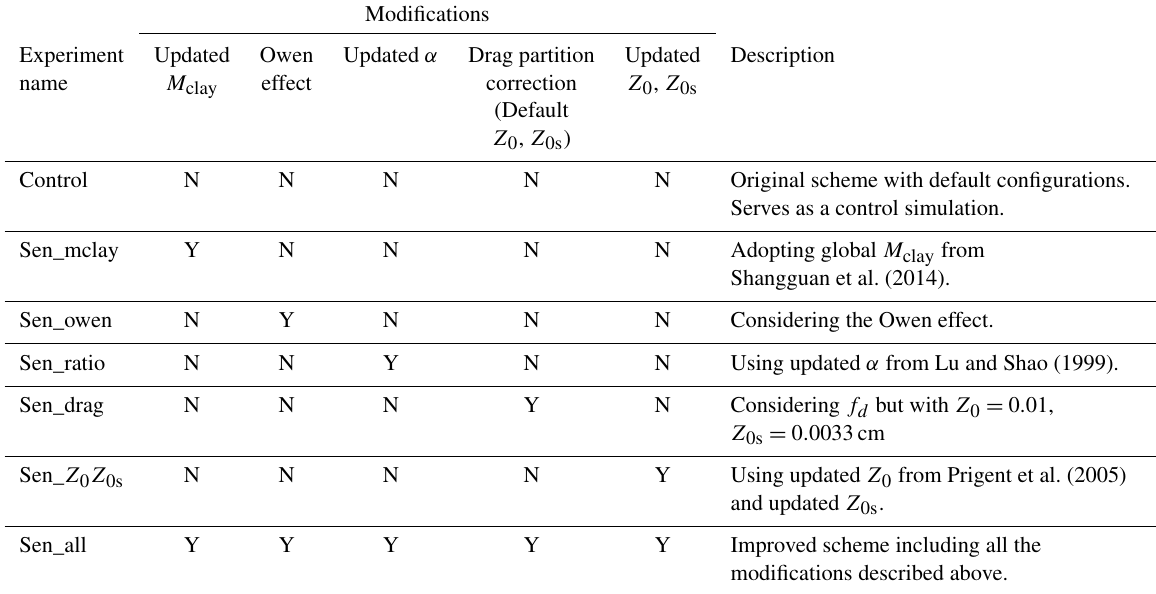
Table 3. Sensitivity experiment design and